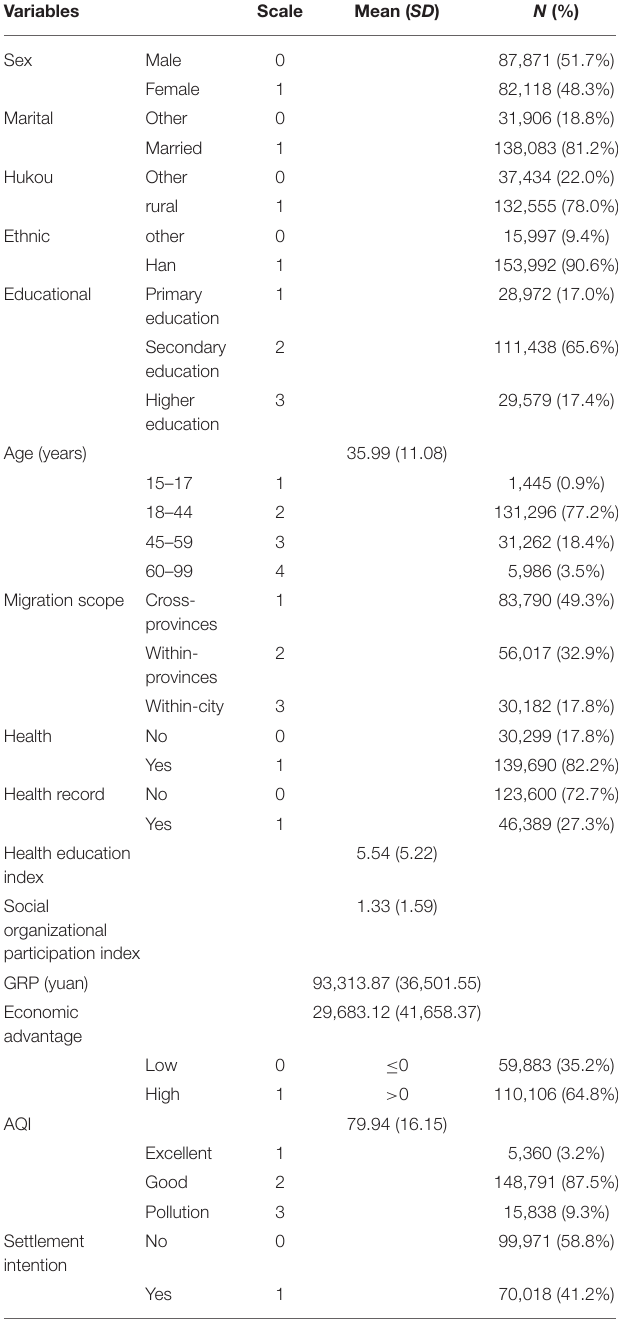
TABLE 1 | Descriptive statistics for original sample and variables